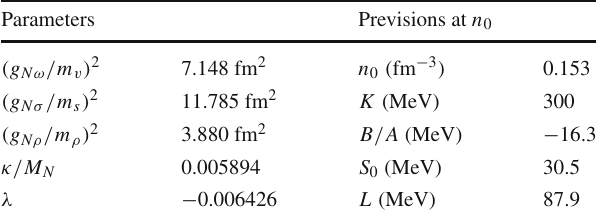
Table 1 Slightly modified GM1 parametrization. Parameters of the modelandnuclearbulkpropertyprevisions. N